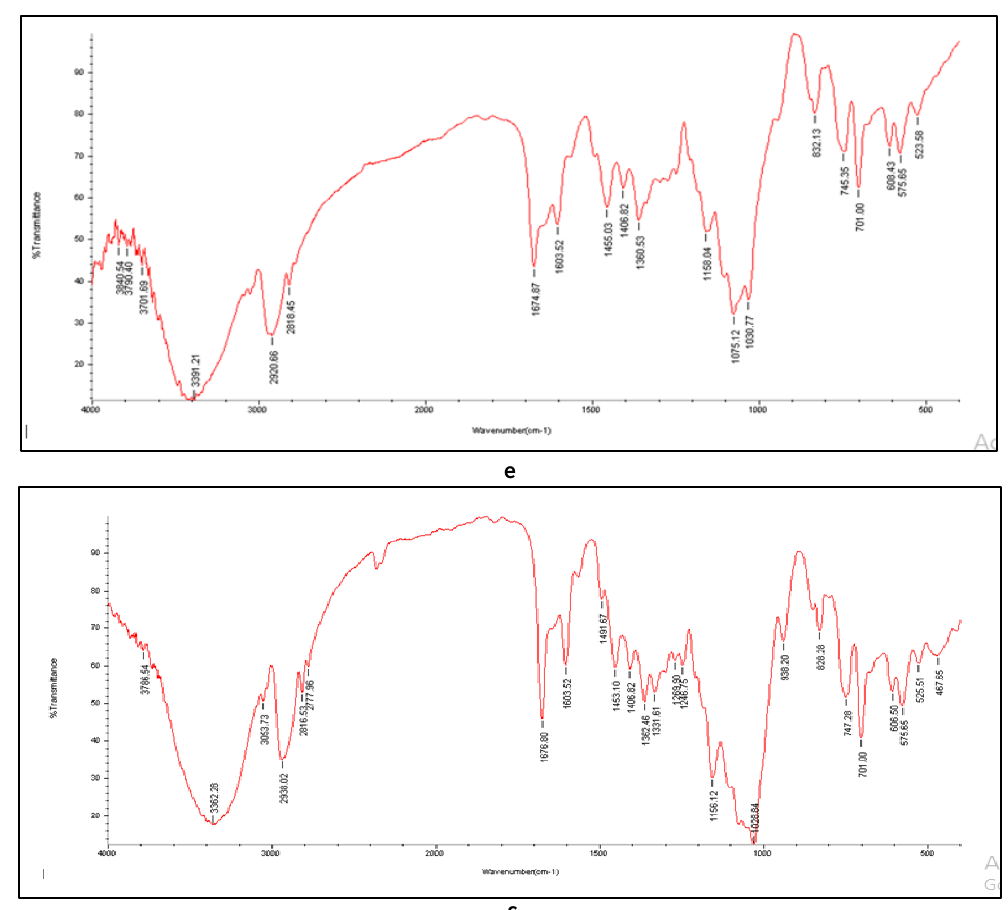
Figure 6. FTIR of: (a)EBS (b)PEG4000 (c)β. cyclodextrin (d)EBS1, (e)PM (f)EBS6 X-ray diffraction (X.